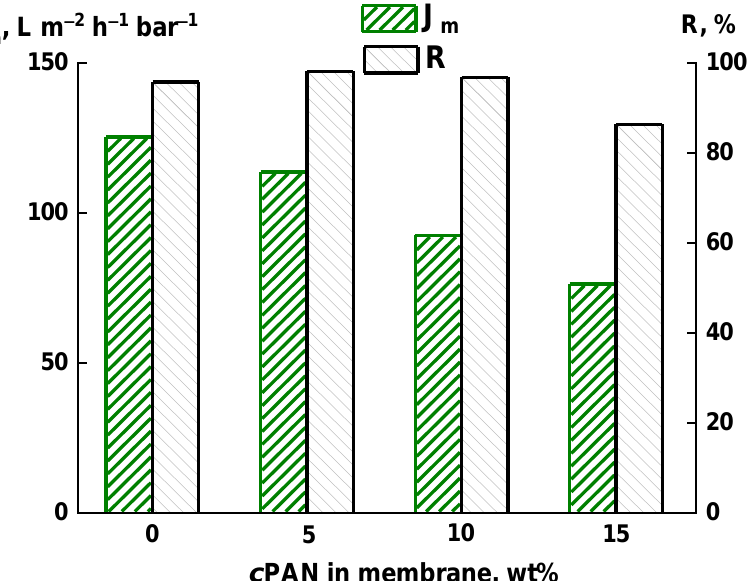
Figure 7. Flux of aqueous BSA ( J m ) and BSA rejection ( R ) vs. c PAN content in the membrane.